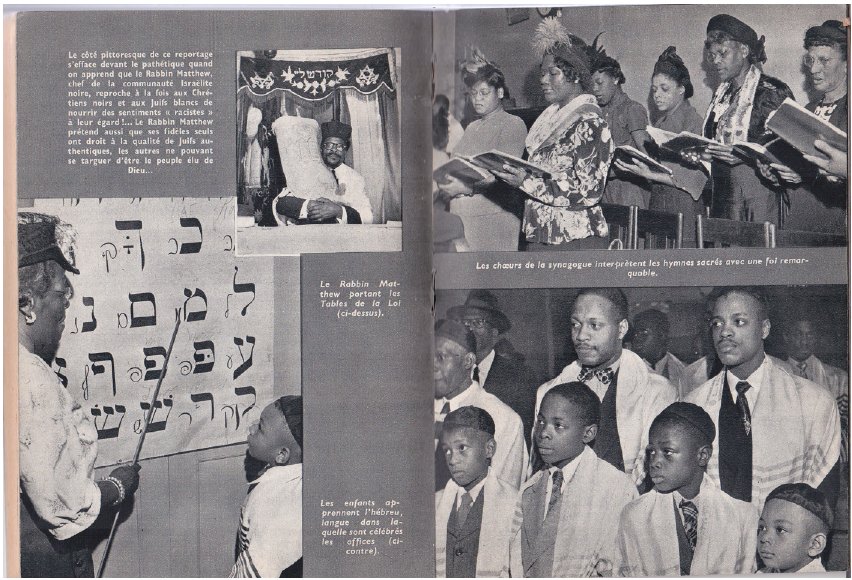
Fig. 4 ‘Avec les Juifs noirs de Harlem’, Caliban , no. 52 (June 1951),